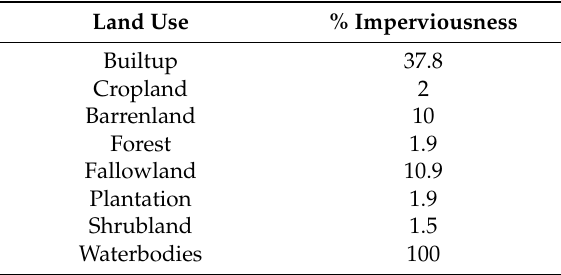
Figure 8. Percent imperviousness map of the study area. Table 7. The percent imperviousness of the study area for the corresponding land-use